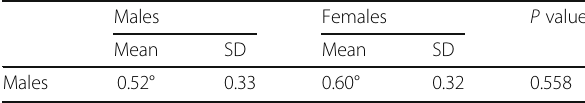
Table 2 Analysis of palatal suture opening pattern between males and